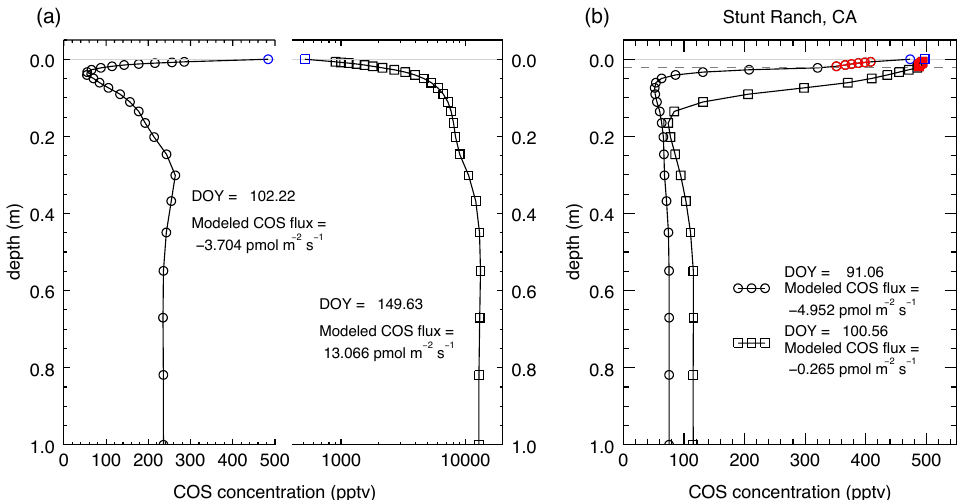
Figure 7. Typical simulated profiles of COS concentration. (a) COS profiles of a strong uptake case (circles) and a strong emission case (squares) at SGP. The right side of the x axis is on logarithmic scale. (b) COS profiles during the wet period (circles) and the dry period (squares). Blue color is used for the atmospheric concentrations, and red for the concentrations in the litter layers in (b) .